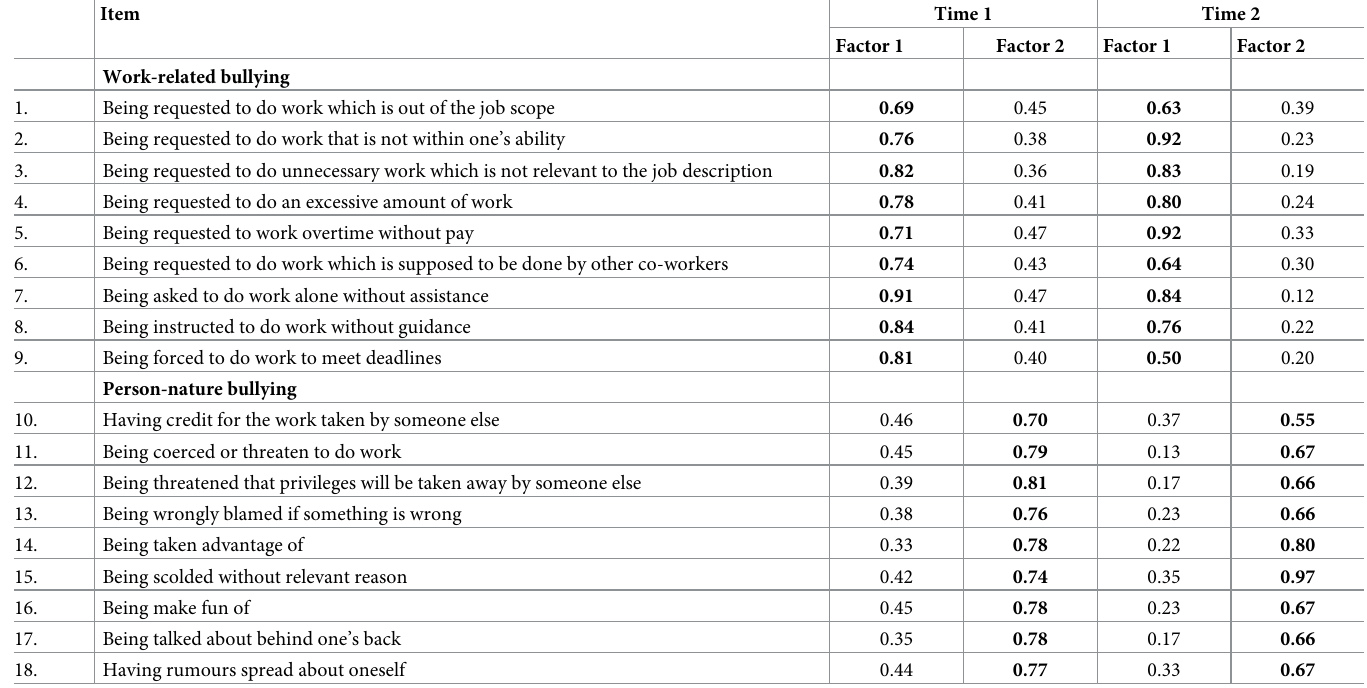
Table 7. Factors loadings for 2Within and 1Between (2W1B) Model for 18 items at Time 1 and Time 2.